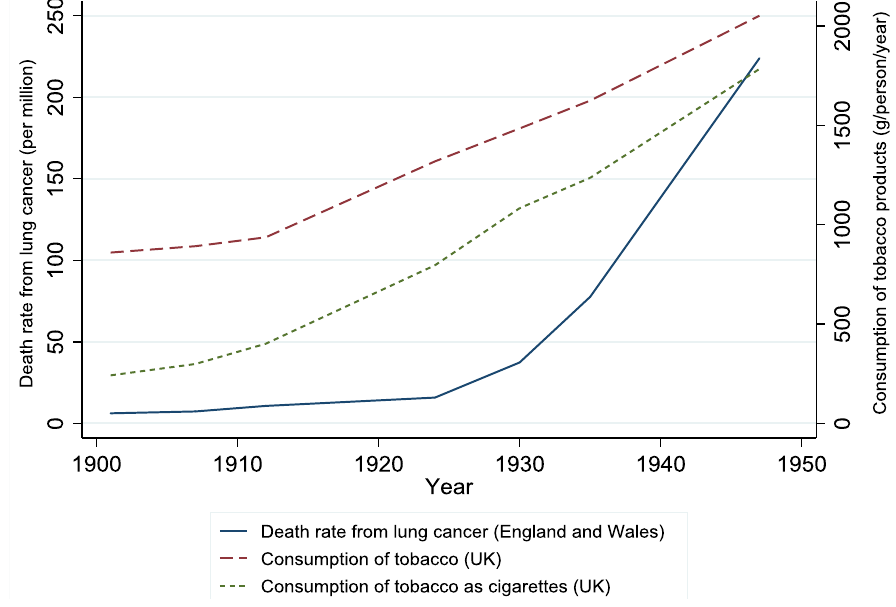
Figure 2. Death rate from lung cancer and consumption of tobacco and cigarettes over time in the United Kingdom (redrawn using data from [17]).